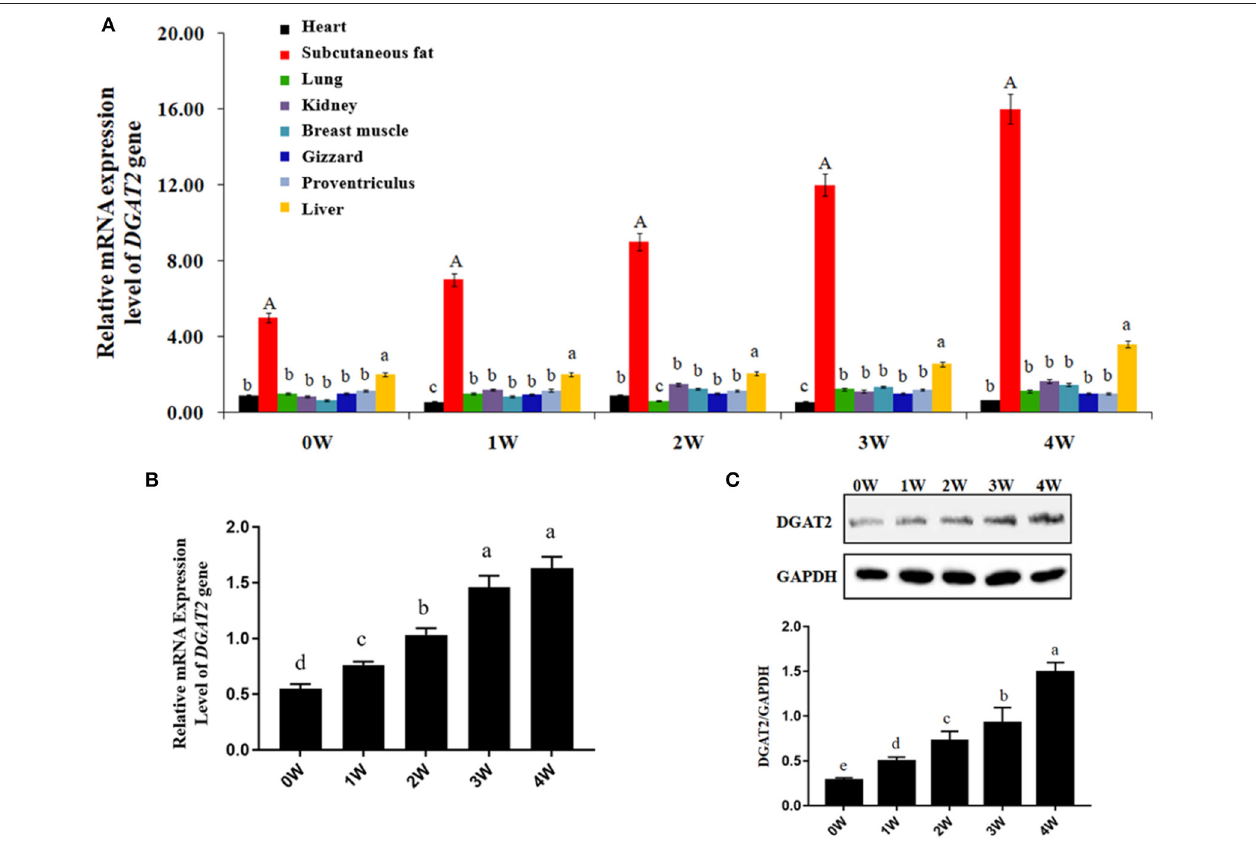
FIGURE 1 | Gene and protein expression levels. (A) Absolute quantification of mRNA expression levels of diacylgycerol acyltransferase 2 (DGAT2) gene in different tissues at 0, 1, 2, 3, and 4 weeks post-hatching in domestic pigeons. Bars with capital letter and lowercase letter mean highly significant differences ( p < 0.01) and significant differences ( p < 0.05), respectively. Data were represented as mean SE for 10 pigeons ( n 10). (B) Relative mRNA expression levels of DGAT2 gene in ± = the breast muscle of domestic pigeons at 0, 1, 2, 3, and 4 weeks post-hatching. Bars with lowercase letters meant significant differences ( p < 0.05). Data were represented as mean SE for 10 pigeons ( n 10). Group 0 week was used as reference. (C) Western blot analysis of DGAT2 protein in the breast muscle of ± = domestic pigeons at 0, 1, 2, 3, and 4 weeks post-hatching, normalized with GAPDH. Bars with different lowercase letters were significant differences ( p <